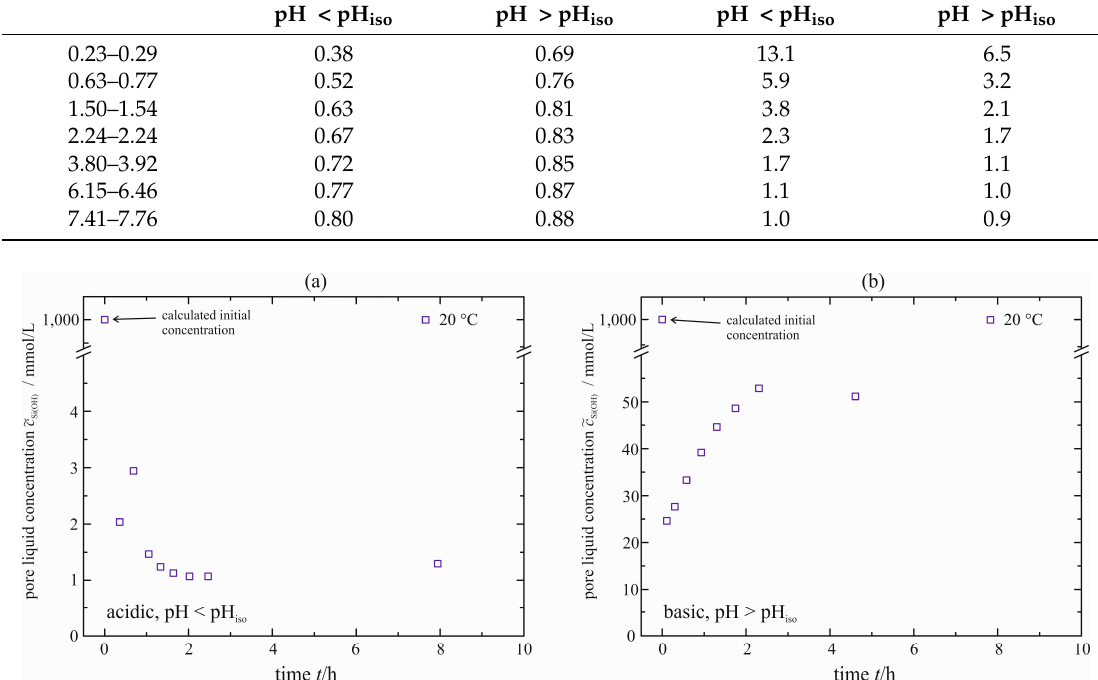
Figure 13. Concentration of monomeric silicic acid in the pore liquid, acid-catalyzed ( a ) and base-catalyzed ( b ), enforced syneresis for Δ p = 3.80–3.92 bar.